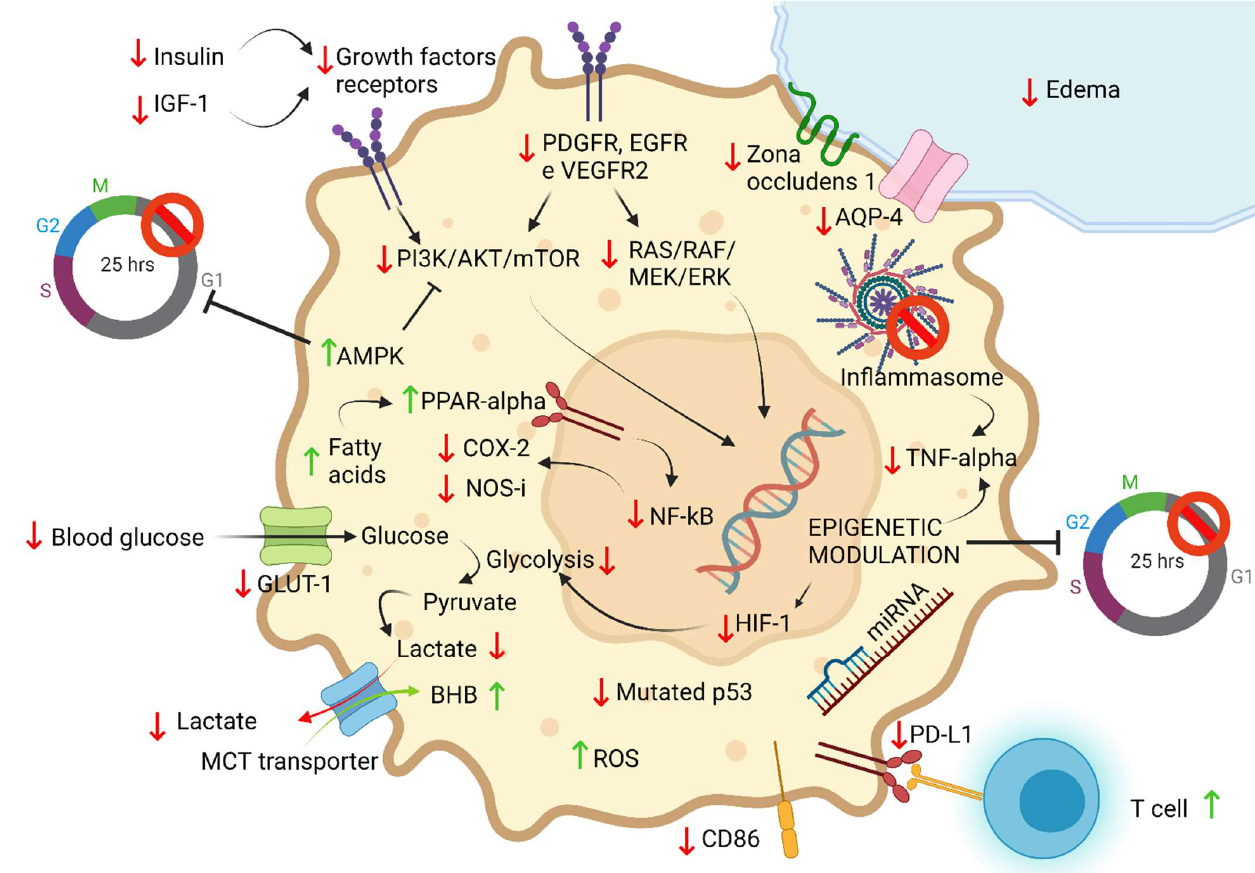
Figure 4. Main mechanisms of functioning of ketogenic diet against cancer cell described in the literature ( ↑ = increased; ↓ = reduced).